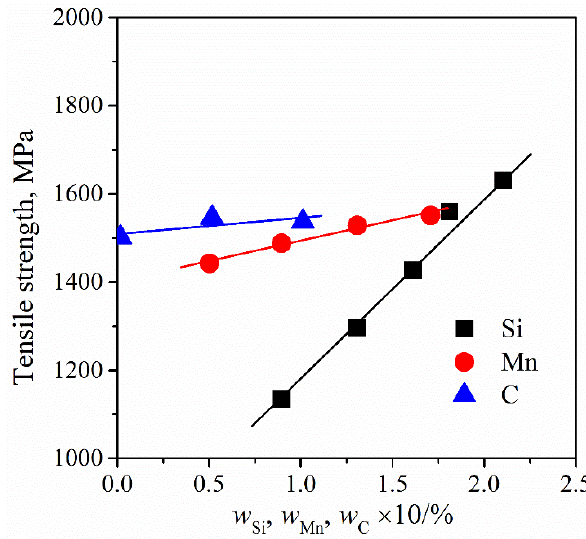
Figure 7. Relationship between the strength, carbon content, and alloying elements of martensitic steel [35,55]. This figure is reproduced based on [35,55].